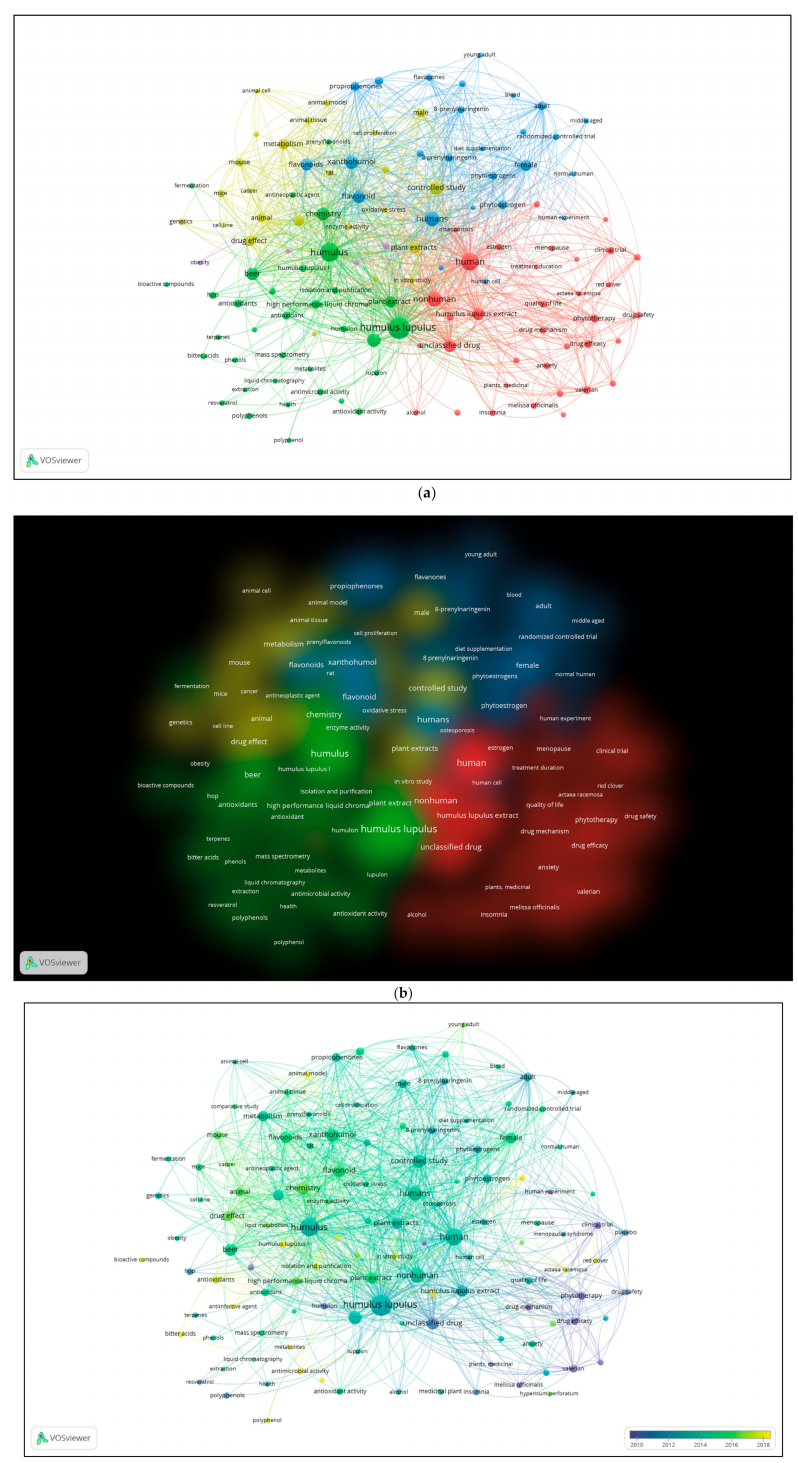
Figure 3. ( a ) “Network Visualization” of the keyword co-occurrence network map generated using VOSviewer. ( b ) “Cluster density” of the map generated in VOSviewer. Each density representing a cluster has a different colour. ( c ) “Overlay visualization” of the keyword co-occurrence network map generated by VOSviewer. The lighter the yellow colour, the more recent the average year of publication of the keywords represented by the nodes. All maps were generated using VOSviewer software from the results of the search performed in Scopus (until 1 September 2022) and subsequent cleaning of the